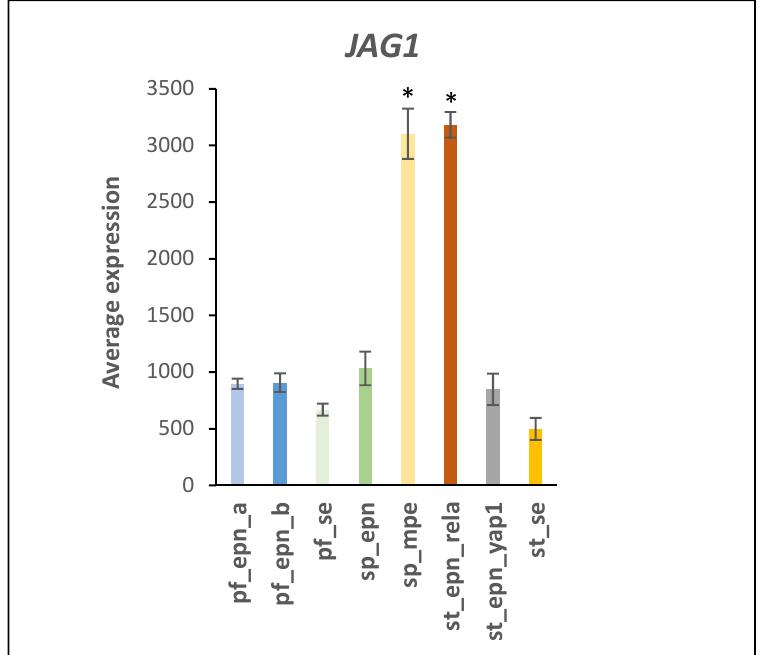
Figure 8. Over-expression of JAG1 in SP_MPE and ST_EPN_RELA subtypes (by Anova, F = 108.15, p = 1.23 × 10 − 64 ). * significantly different from all other groups not indicated by *, at p < 0.001. Dataset GSE64415.